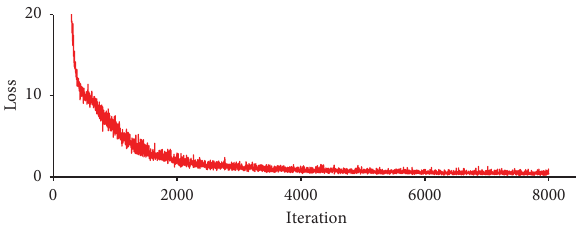
Figure 12: The iterative convergence process of the Loss curve for the improved RDCNN training.